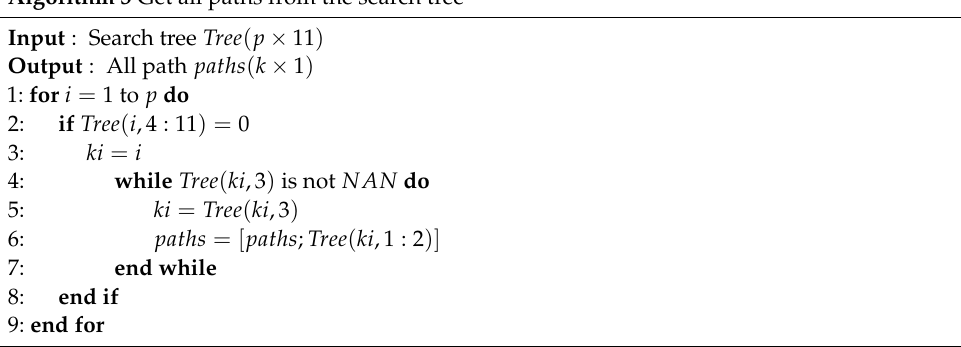
Algorithm 3 Get all paths from the search